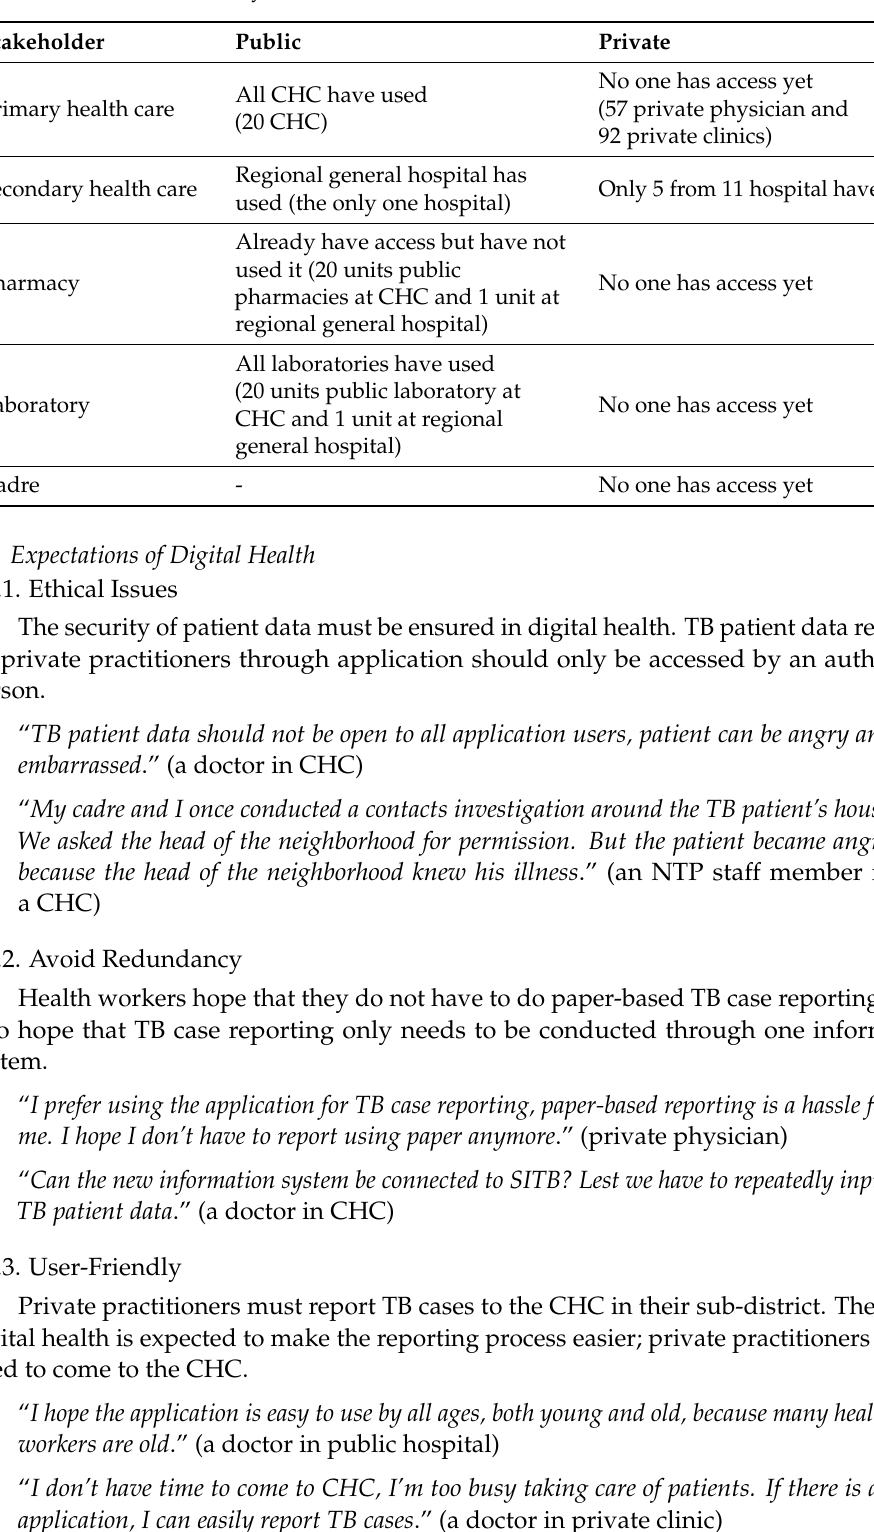
Table 4. Utilization of SITB by stakeholders in